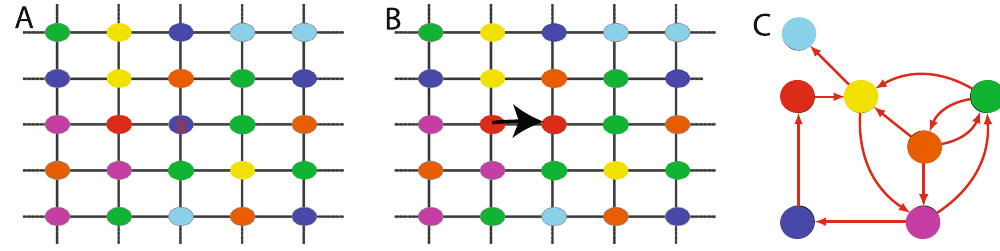
Figure 1. Graphical representation of our model. ( A , B ) The population dynamics is stochastic: at each time step a randomly chosen individual of a given species (denoted by the color) die and it is replaced by another species that is also picked at random and give birth to an offspring. The species birth rate depends on the species population abundance and on the species interaction matrix ( C ) - as given by Eq.